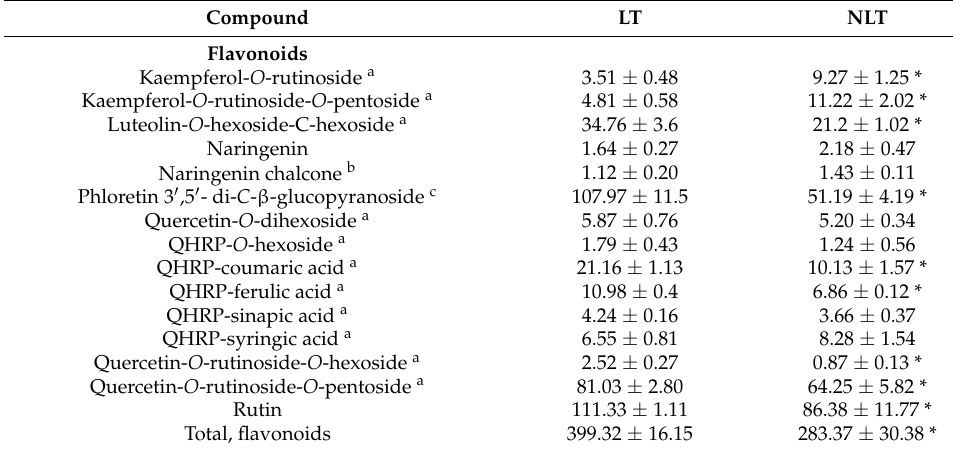
Table 1. (Poly)phenolic composition of local (LT) and non-local (NLT) tomatoes. Data expressed as mean values in µ g/g dry weight ± SD ( n =